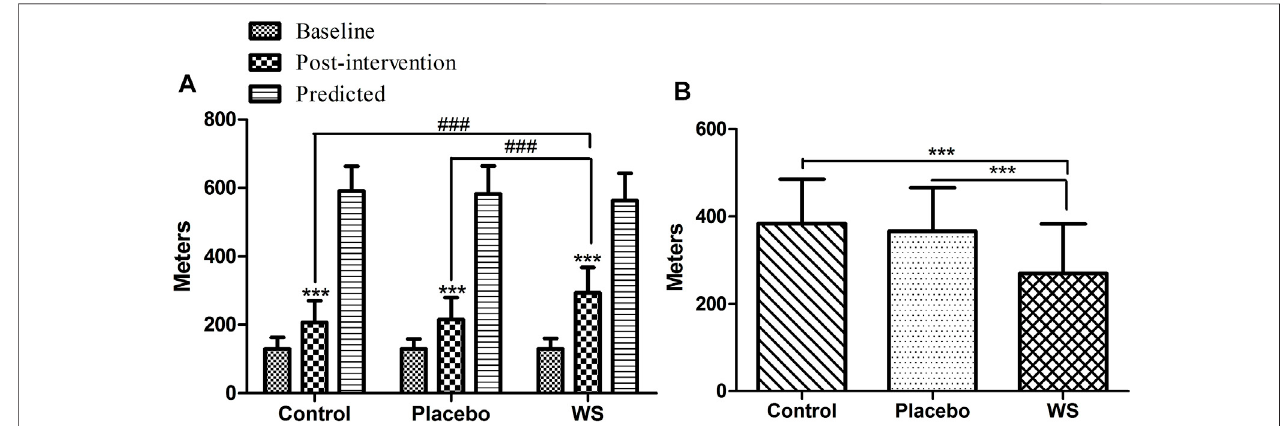
FIGURE 4 | Effect of interventions on exercise tolerance and lung functioning, measured by 6MWT: (A) Mean distance walked during 6 MWT (in meters) at the baseline and at the end of the study. (B) Difference of post-intervention 6MWT value from predicted values *** p ≤ 0.001 compared with baseline. ### p ≤ 0.001.